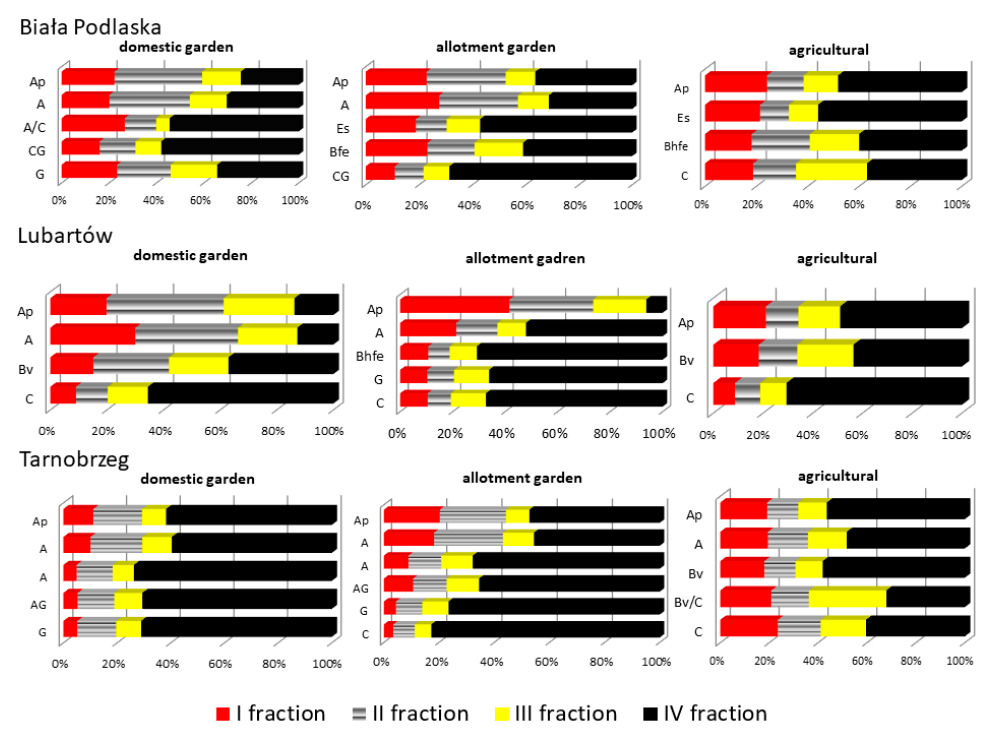
Figure 3. Percentage content of Cu fractions in silty soils.